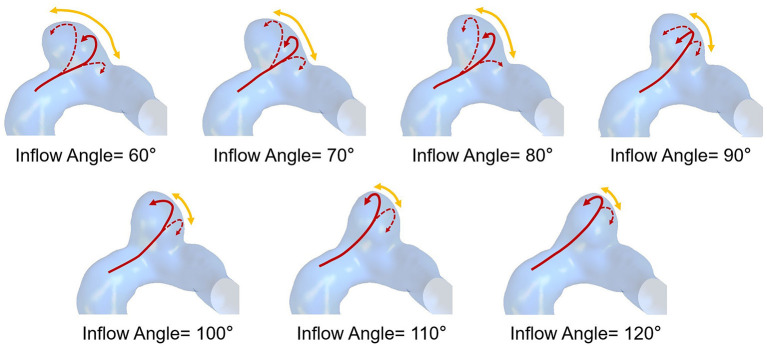
The flow pattern of seven IA models exhibiting different inflow angles at peak systole (The red solid arrows represent the direction of inflow jet, the dashed arrows represent the separate blood flow, and the yellow arrows represent the impingement region).